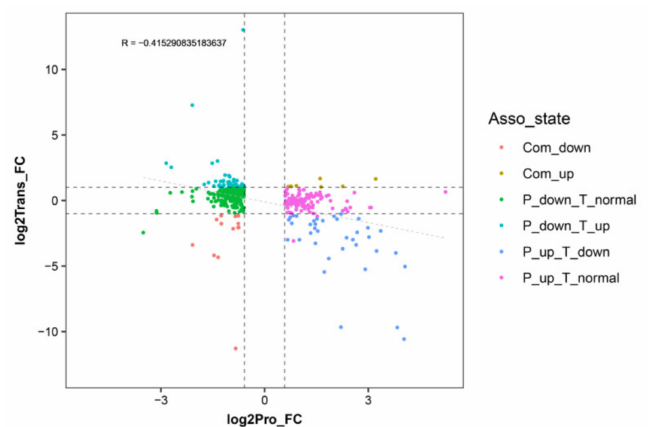
Figure 3. Correlation analysis between differentially expressed genes and proteins in WT and T51 samples. The x -axis illustrates the expression pattern of the differentially expressed proteins (DEPs), and the y -axis illustrates the expression pattern of their corresponding DEGs in WT and T51